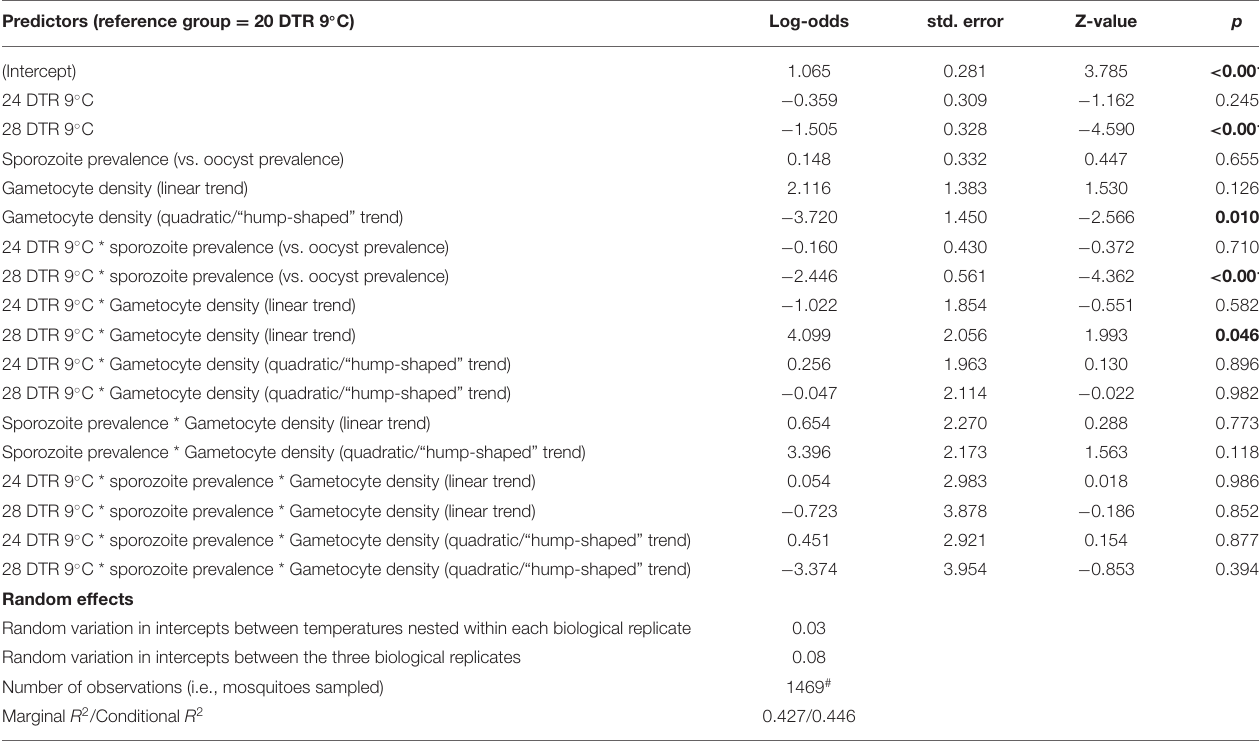
TABLE 1 | Statistical models for prevalence of oocysts and sporozoites in midguts and salivary glands respectively. Predictors (reference group = 20 DTR 9 ◦ C) Log-odds std.